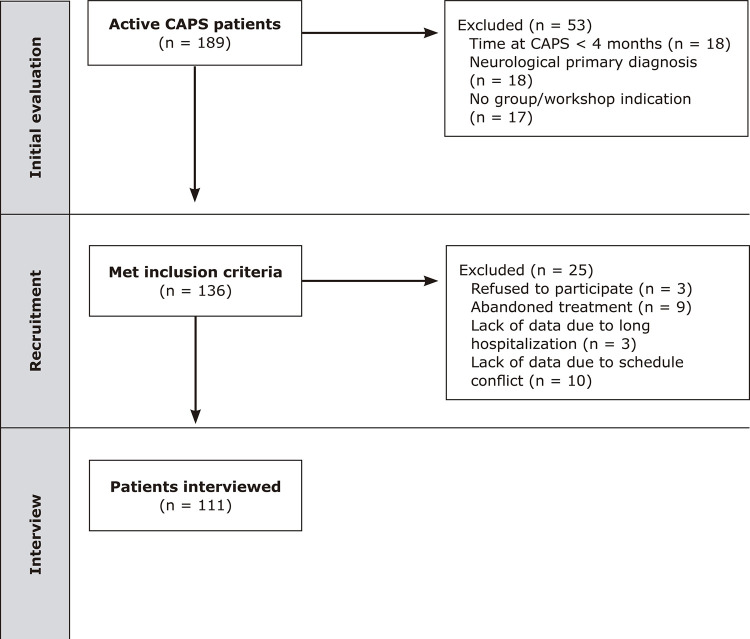
Study flowchart. CAPS = Centros de Atenção Psicossocial (psychosocial care centers).